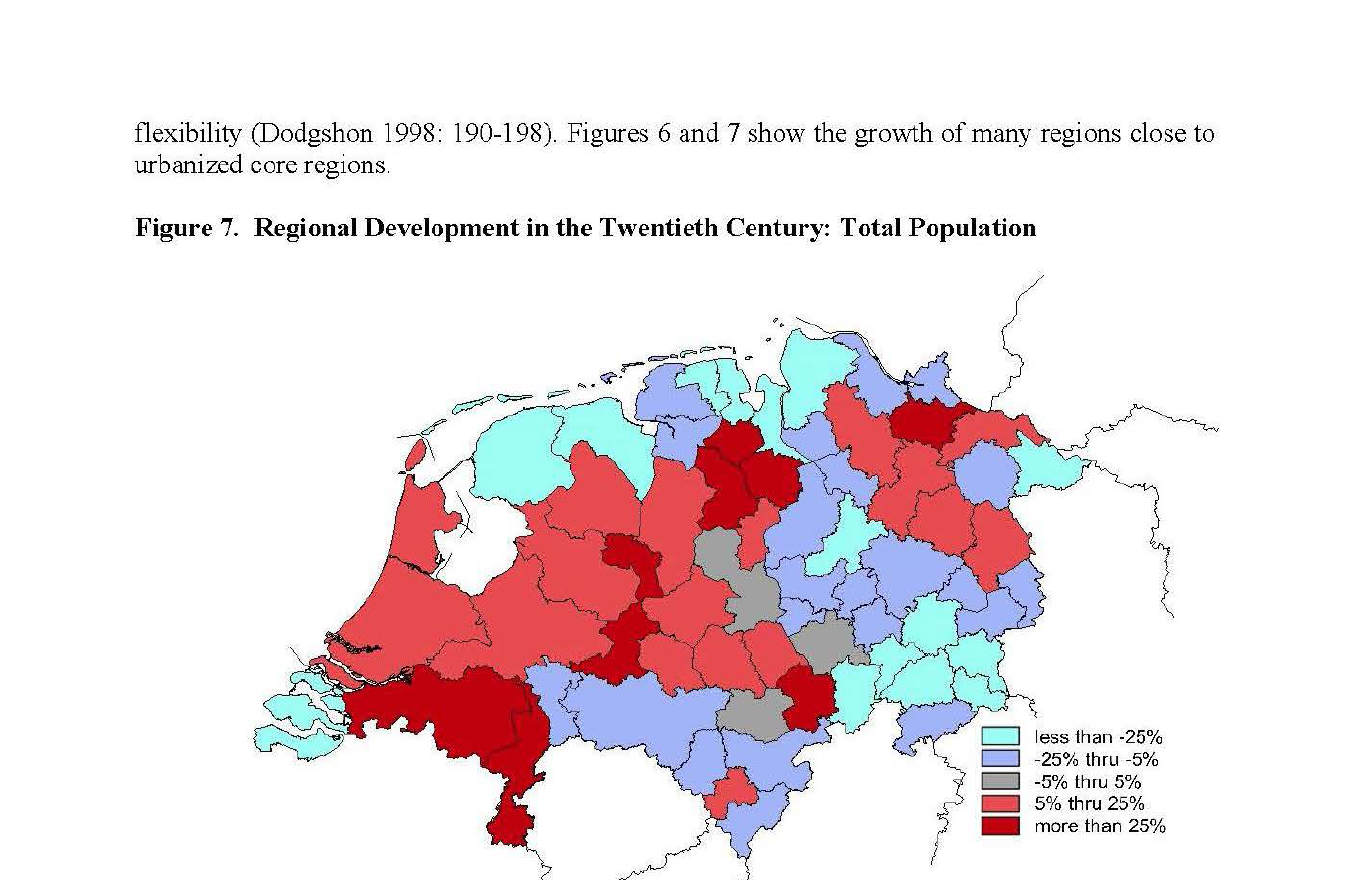
Figure 7. Regional Development in the Twentieth Century: Total